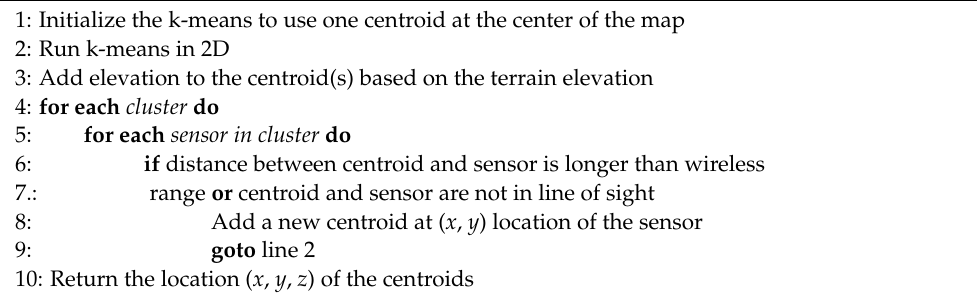
Algorithm 1. Calculation of the positions of the download